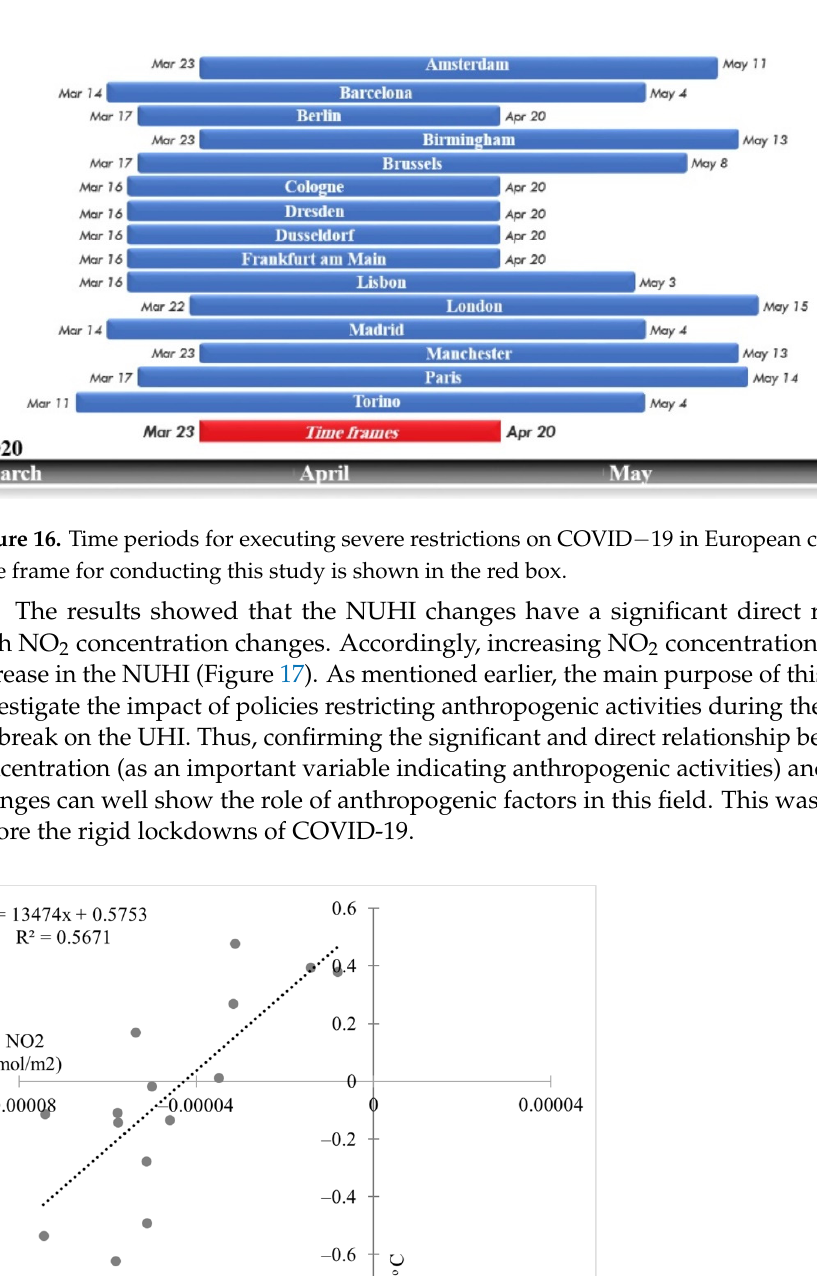
Table 9. Correlation matrix: Correlation between NUHI, NLST, NL, and NO 2 changes in each of the studied cities. Figure 17. Relationship between NO 2 and NUHI changes in European major cities.